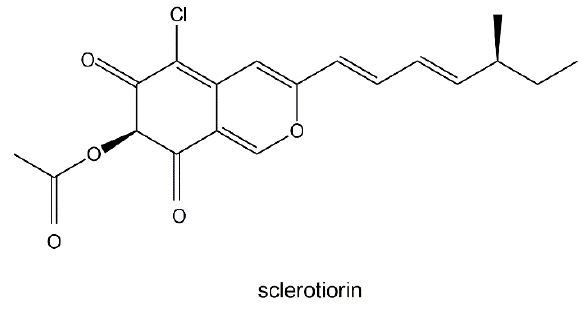
Figure 5. Chemical structure of the pigment sclerotiorin produced by Penicillum sclerotiorum 2AV2.